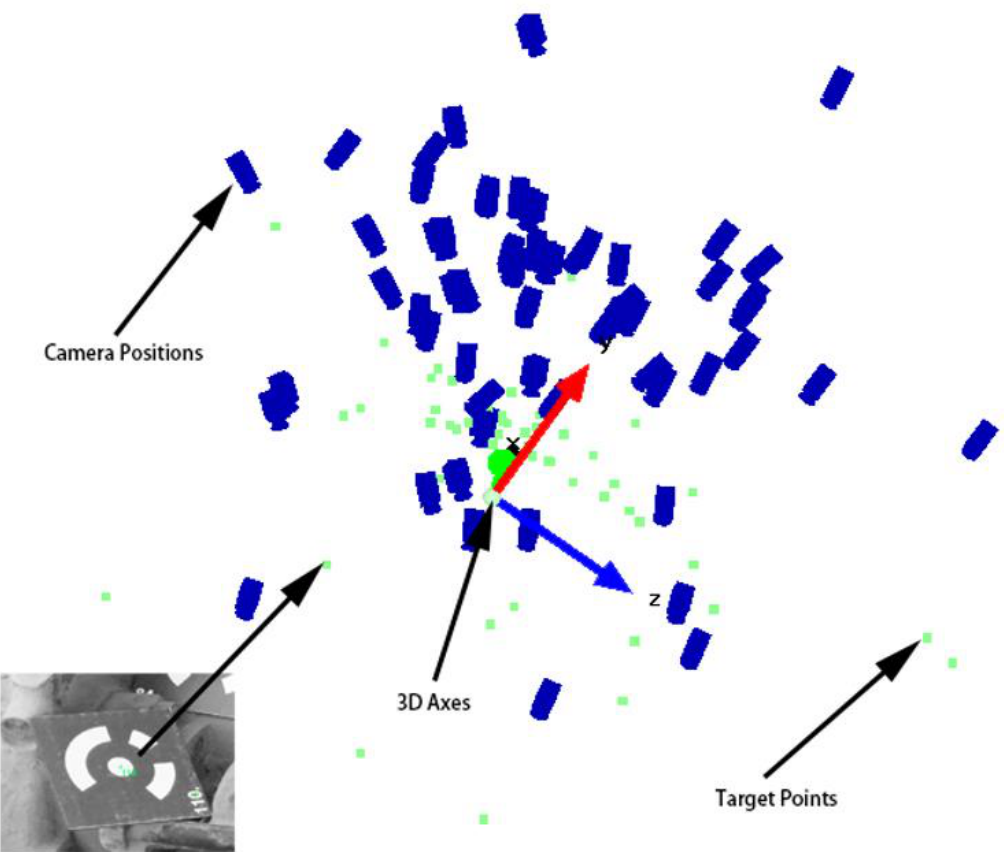
Figure 4. Positions of targets and cameras.